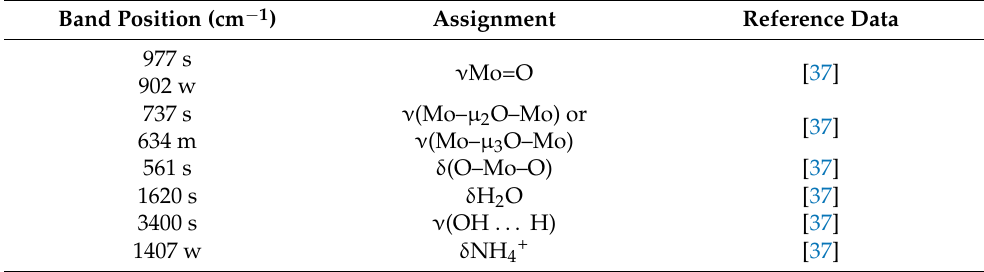
Table 1. Assignment of several bands in the IR spectra of molybdenum–tungsten nanoparticles. Band Position (cm − 1 )